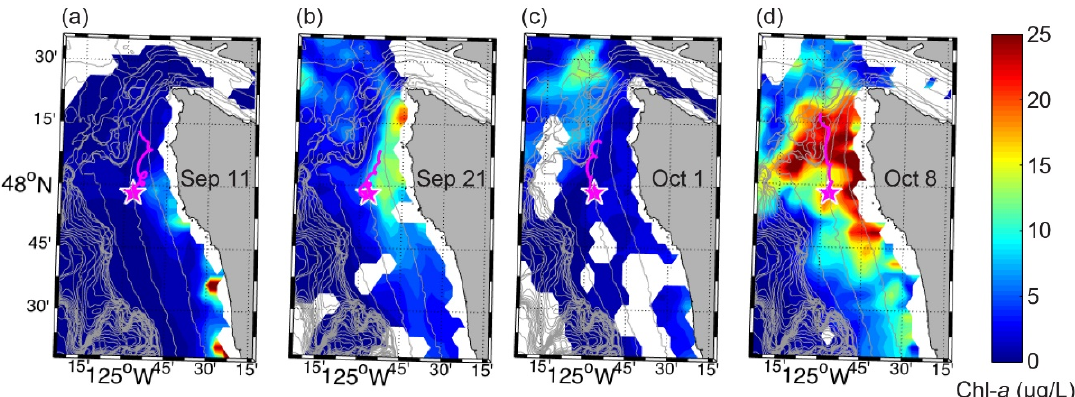
Figure 10. VIIRS daily, near-surface chlorophyll- a concentrations with 50-m bathymetry contours overplotted for ( a ) 11 September, ( b ) 21 September, ( c ) 1 October, and ( d ) 8 October of 2017. Local time (Pacific Daylight Time) is approximately 13:45 for each day. Gaps in coverage are largely due to cloud cover and fog. The magenta star shows the location of the ESP mooring. The magenta line shows 2-day duration progressive vector tracks calculated by backwards-integrating NEMO-SS ADCP measurements in time, suggesting a potential past trajectory of water arriving at the mooring site.